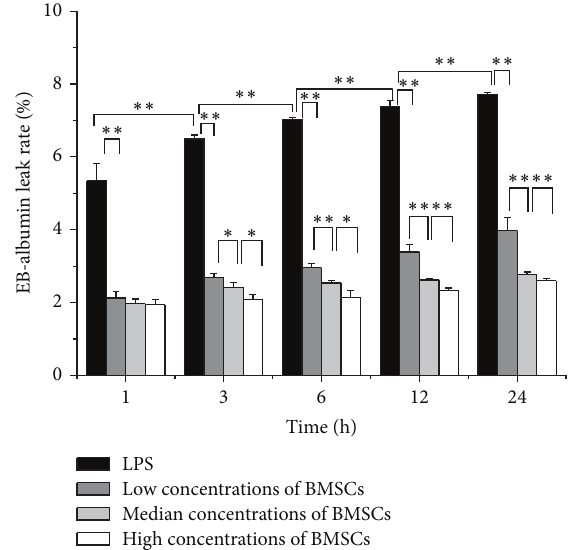
Figure 1: Effect of BMSCs on the barrier permeability of HUVECs. HUVECs were stimulated by LPS at a dosage of 100ng/mL (black bars). In addition, HUVECs were cocultured with indicated concen- trations of BMSCs: low (1 × 10 3 cells/mL, dark grey bars), median (1 × 10 4 cells/mL, light grey bars), and high (1 × 10 5 cells/mL, white bars) for 1, 3, 6, 12, and 24 h followed by measuring permeability as described in Section 2. All results are means ± SD of at least three different experiments. ∗ 𝑃 < 0.05 ; ∗∗ 𝑃 < 0.01